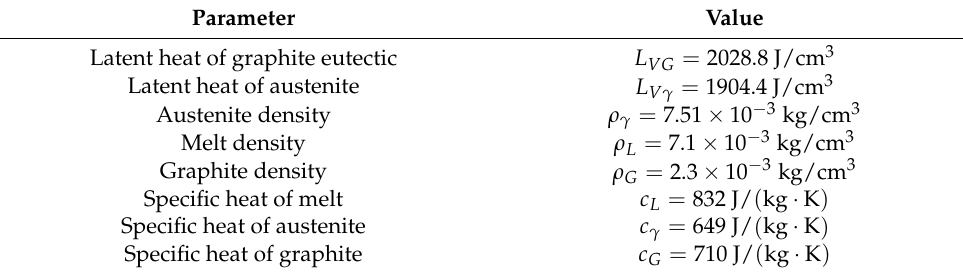
Table 5. Selected thermophysical